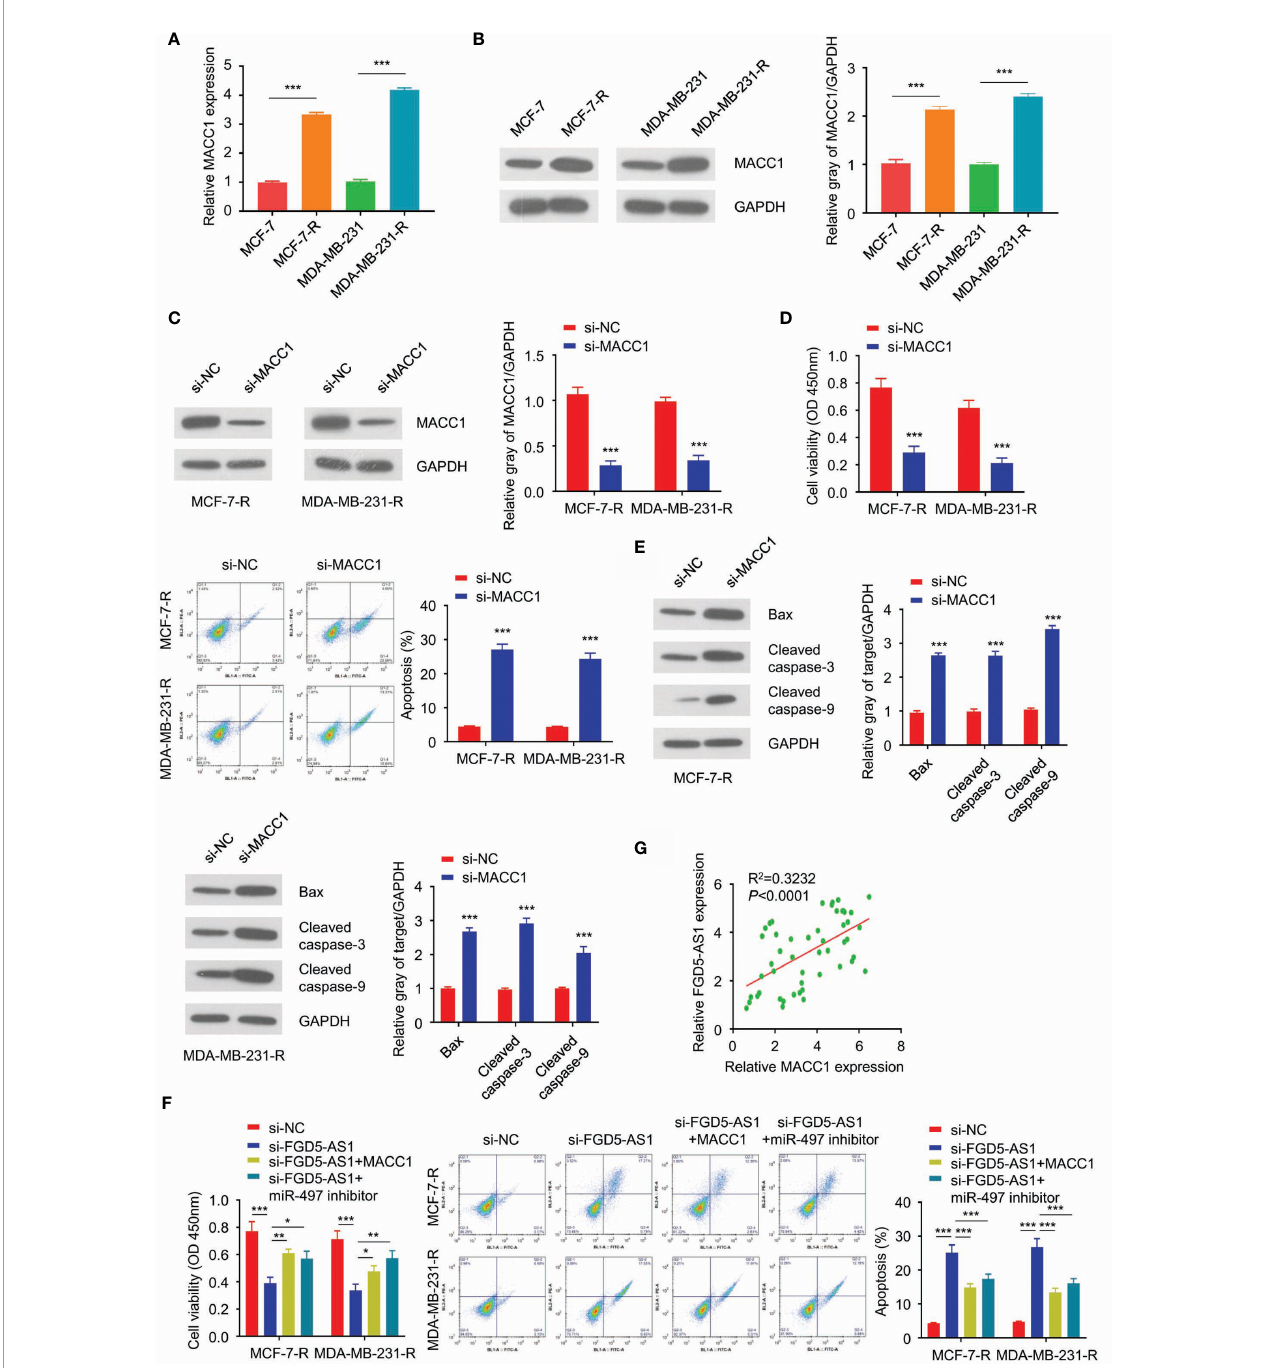
FIGURE 6 | FGD5-AS1 induces MACC1 expression to promote the radio-resistance of BC cells through competitively sponging miR-497. (A) qRT-PCR assays showed that mRNA levels of MACC1 were signi fi cantly upregulated in MCF-7-R and MDA-MB-231-R cells. (B) WB analysis showed that the protein level of MACC1 was increased in the radio-resistant BC cells. (C) Transfect MCF-7-R or MDA-MB-231-R cells with human MACC1 siRNA and WB analysis showed the downregulation of MACC1 in transfected cells. (D) CCK-8 assay, colony formation assay, and fl ow cytometry analysis indicated that MACC1de fi ciency decreased the survival fraction with ionizing radiation, and led to more apoptosis in BC cells. (E) The western blotting analysis showed MACC1 de fi ciency signi fi cantly increased the protein levels of Bax, cleaved caspase-3, and caspase-9 in MCF-7-R or MDA-MB-231-R cells. (F) CCK-8 assays, clone formation assays, and fl ow cytometry analysis, to show that knockdown of FGD5-AS1 decreased the survival fraction and induced more apoptosis in BC cells. However, these phenotypes were signi fi cantly rescued by MACC1 exogenous expression and the inhibition of miR-497. (G) Spearman ’ s correlation analysis showed the positive correlation between FGD5-AS1 and MACC1 expression in 50 BC tissues, as measured by qRT-PCR assays. Intra-group comparison *p < 0.05, **p < 0.01, ***p <